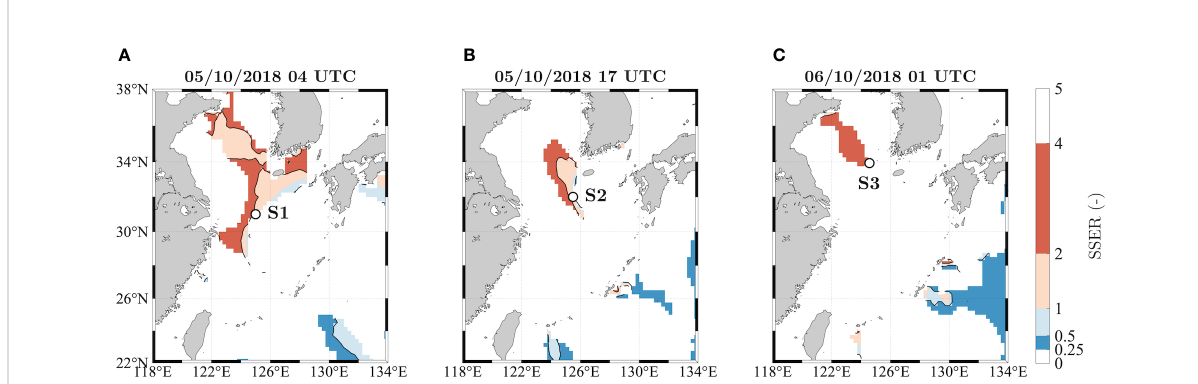
FIGURE 2 Sea-Swell Energy Ratio ( SSER ) of the crossing wave fi elds in the East China Sea and the Yellow Sea during the tropical storm Kong-Rey on 5 October 2018 at 04 (A) and 17 UTC (B) and on 6 October 2018 at 01 UTC (C) . Unimodal spectra within the typhoon fi eld and bimodal spectra with one system clearly dominating in terms of energy (i.e. SSER <0.25 or SSER >4) are masked in white. The selected locations where the model spectra used in this study (S1, S2 and S3) were extracted are shown with a white